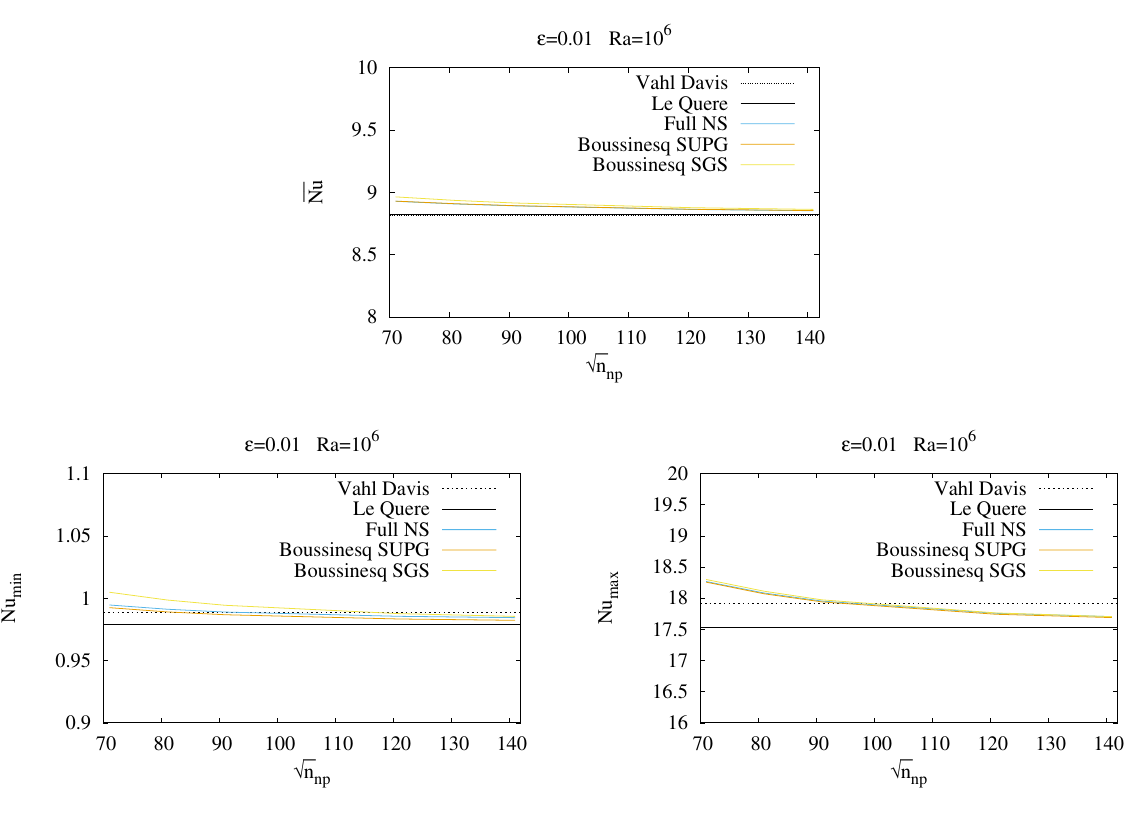
Figure 8. Buoyancy-driven square cavity. Nusselt numbers along hot vertical wall for (cid:101) = 0.01 and HH